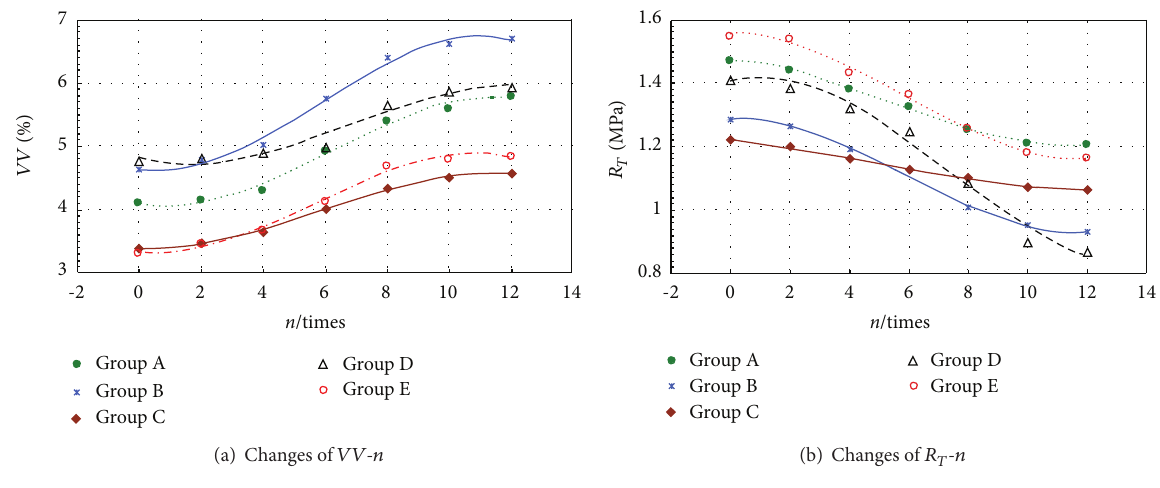
Figure 6: Testing results of 𝑉𝑉 and 𝑅 𝑇 .